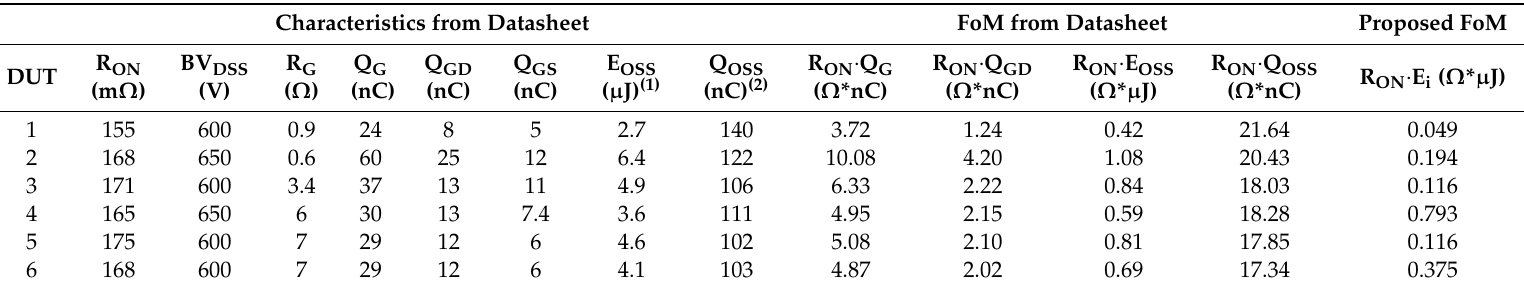
Table 1. List of Superjunction (SJ)-MOSFETs explicitly for LLC primary side with main electrical characteristics and figures of merit (FoMs). DUT, device under test. Characteristics from Datasheet FoM from Datasheet Proposed